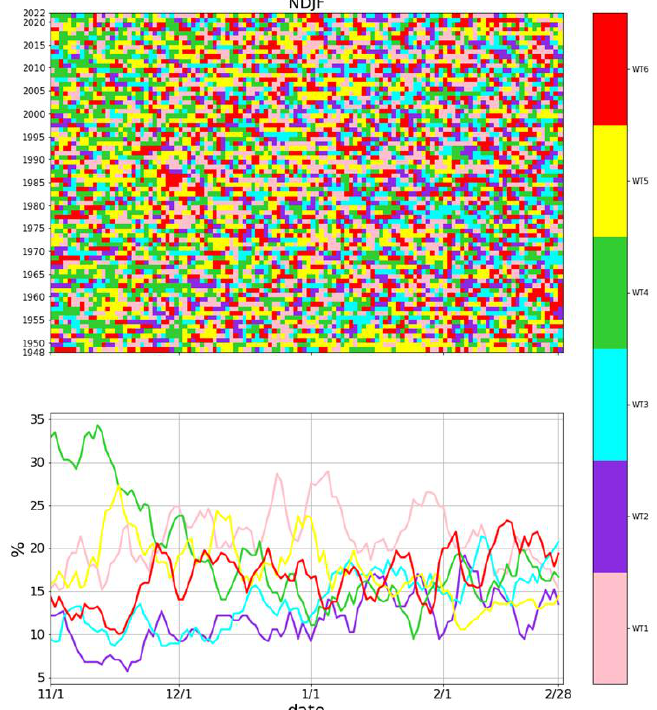
Figure 4. The daily weather types (WTs) in the winter of 1948–2022 (top). The 74-year averaged frequency (percentage) of the 6 WTs from November 1 to February 28 (120 days/year); a 5-day running average was conducted (bottom). Color: WT1 (pink), WT2 (purple), WT3 (light blue), WT4 (green), WT5 (yellow), WT6